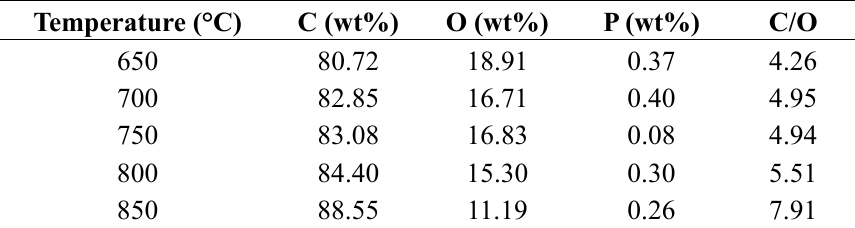
Table 2. Elemental composition of the surface of BACFs.